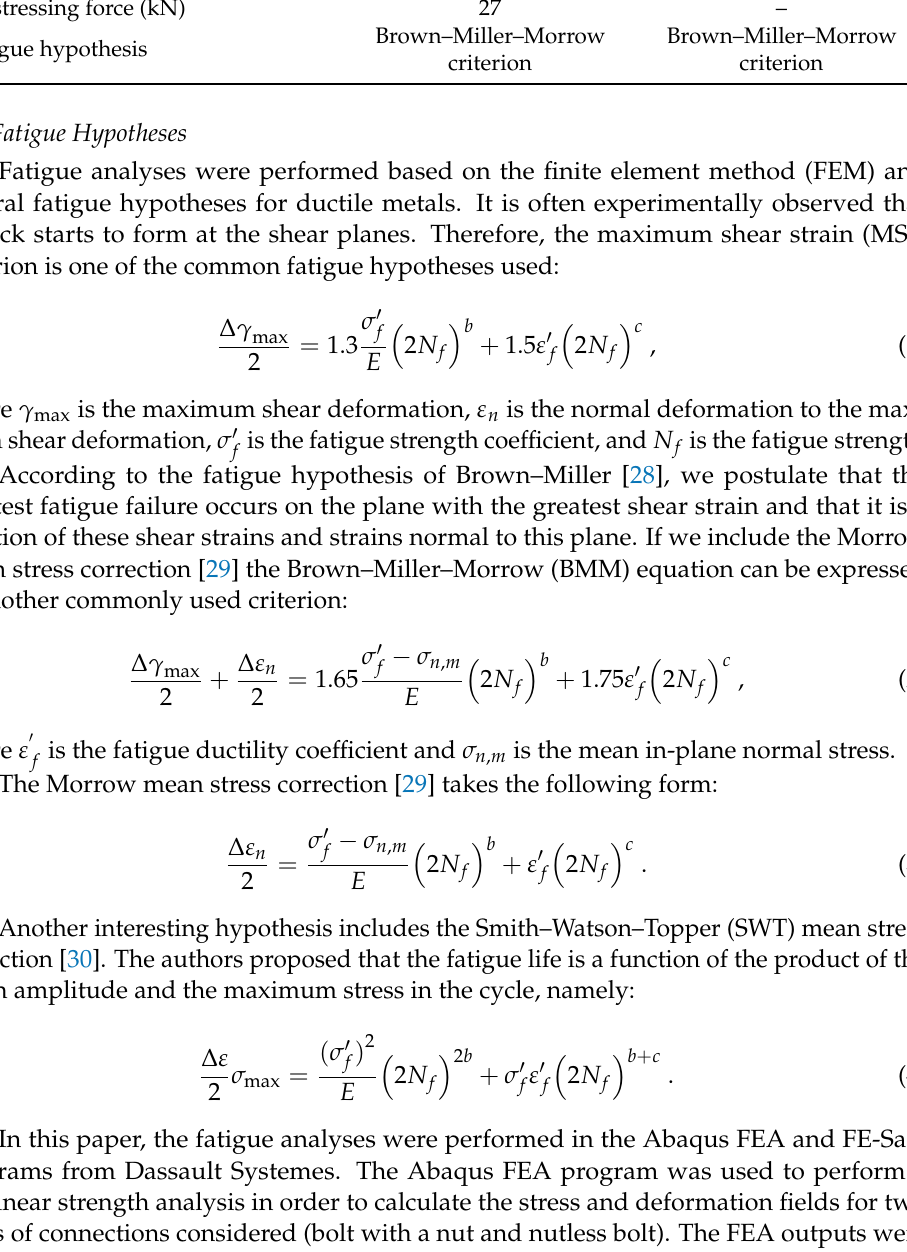
Table 1. Reference values of the parameters considered in the parametric study. Parameter Bolt with Nut Nutless Bolt Bolt diameter (mm) 12.0 13.2 Yield strength of the bolt (MPa) 450 340 Coefficient of friction between plates 27